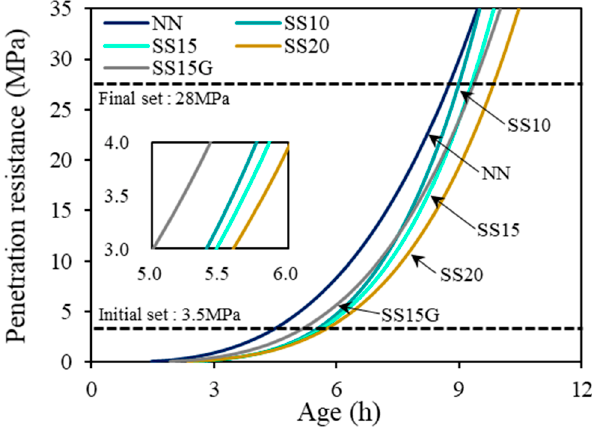
Figure 5. Initial and final setting curve.